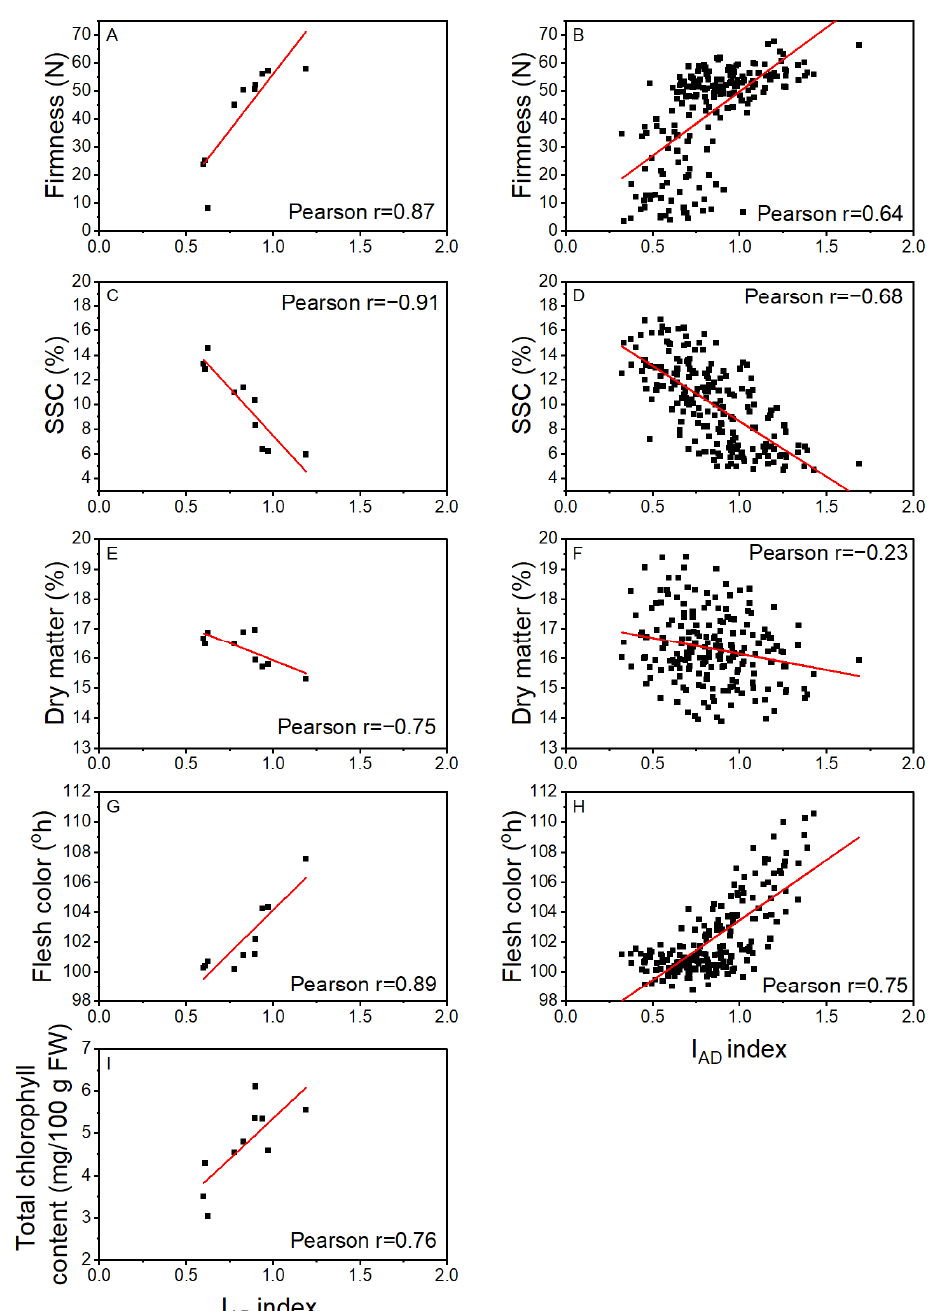
Figure 3. Correlation coefficients for the relationships based on sample average ( A , C , E , G , I ) and individual fruit ( B , D , F , H ) data for at-harvest measurements of I AD and: fruit firmness ( A , B ), soluble solids content (SSC) ( C , D ), dry matter ( E , F ), flesh color ( G , H ). and total chlorophyll ( I ) for Actinidia chinensis var. chinensis ‘Donghong’ fruit harvested between 119 and 182 days after full bloom in 2020. The red lines are the fitted linear regressions, with Pearson correlation coefficients provided. Sample sizes, n = 10 for averages, and 200 for individual fruit.